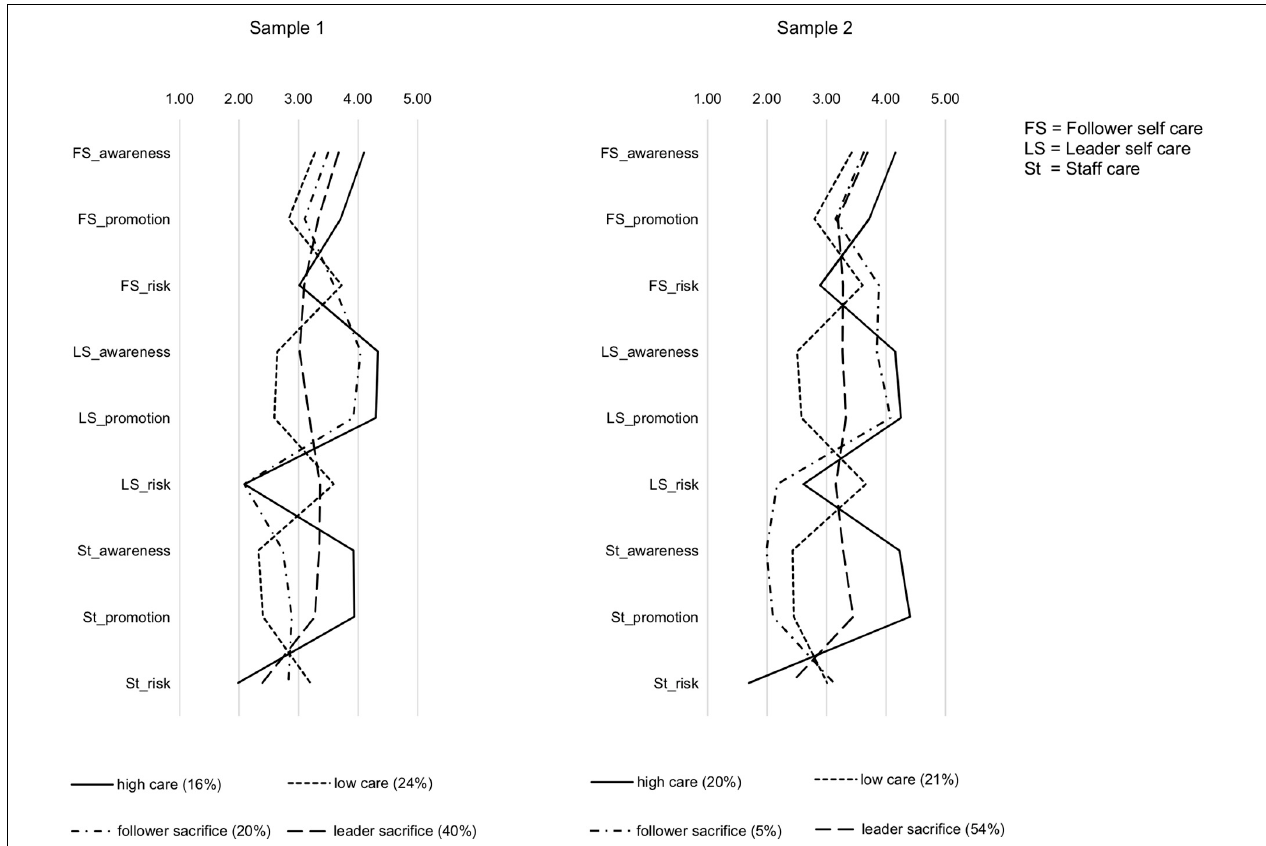
FIGURE 1 | Profiles of health-oriented leadership: Mean scores of follower self care variables (awareness, promotion, risk), leader self care variables (awareness, promotion, risk) and staff care variables (awareness, promotion, risk) across the four